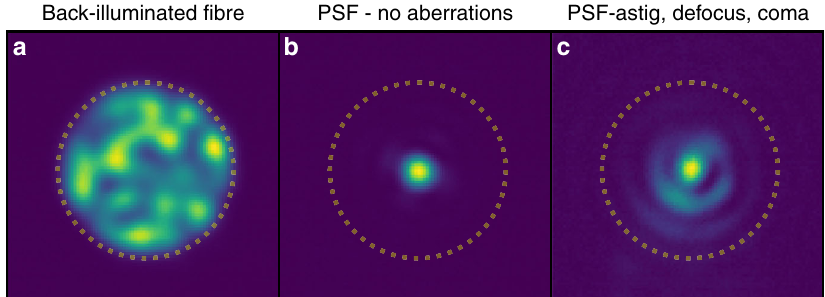
Fig. 4 Near- fi eld image of the photonic lantern ’ s multimode end face. The dotted line marks the outer extent of the fi bre core, which has radius of ~3 λ / D . a The lantern is back-illuminated by injecting light into the multi-core outputs (with random intensity distribution), exciting some combination of the fi bre ’ s modes, visible here. b Back-re fl ected image of the multimode fi bre when no aberrations are applied. c Back-re fl ected image of the multimode fi bre when several aberrations are